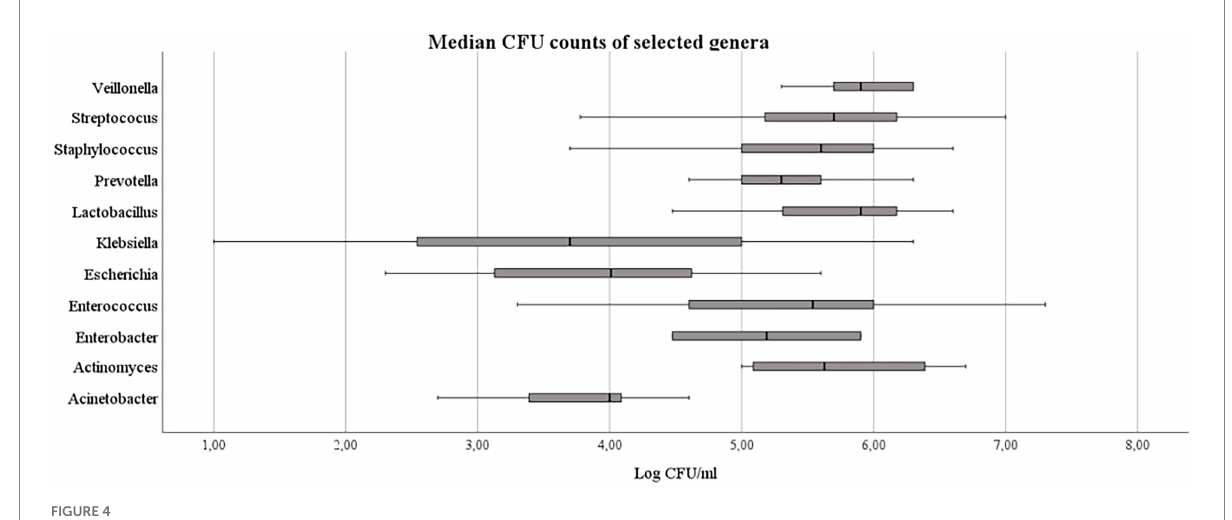
FIGURE 4 CFU counts of selected identified bacteria